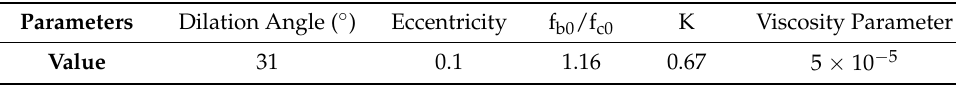
Table 6. The parameters of mortar-damaged plasticity [26].